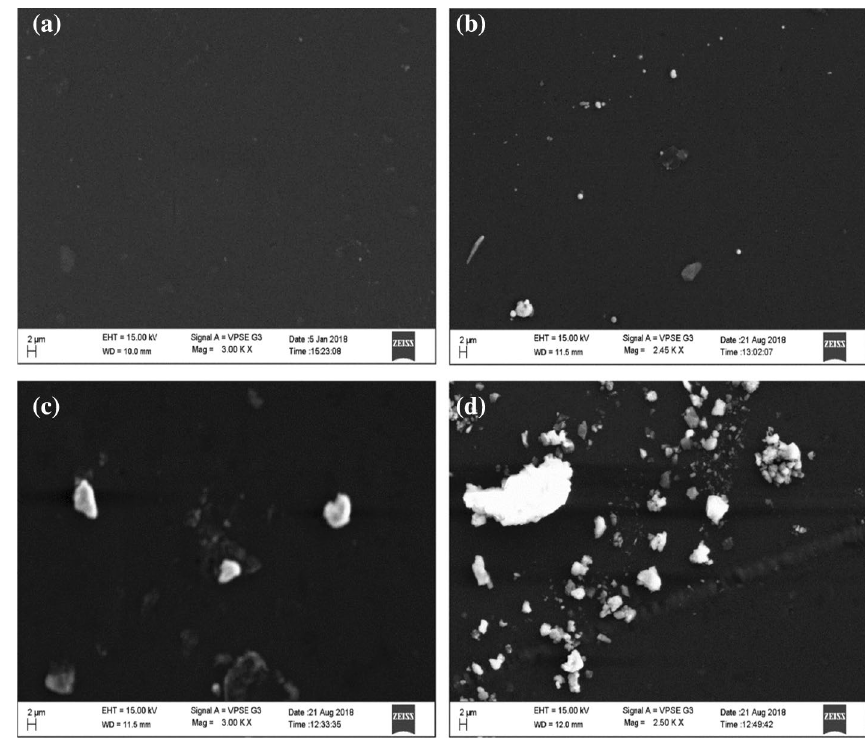
Fig. 4 SEM images of a PVA, b PVA/MA, c PVA/TA, and d PVA/LA